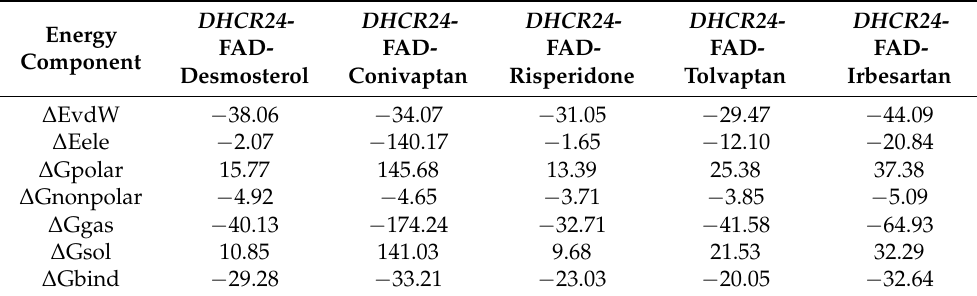
Table 3. The binding affinity of complexes resulting from MM-GBSA analysis with desmosterol or hits